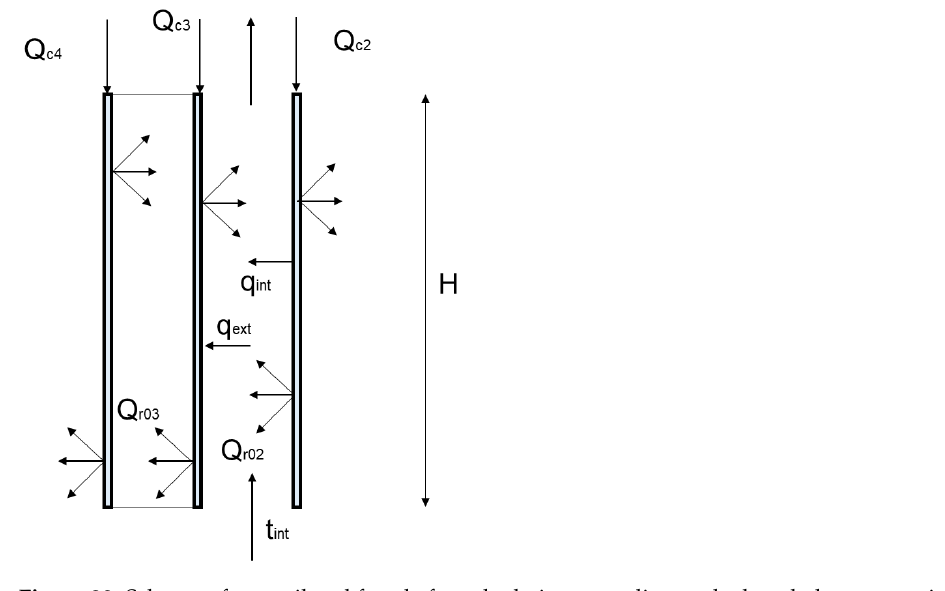
Figure 20. Scheme of a ventilated facade for calculation according to the heat balance equations on glass surfaces.